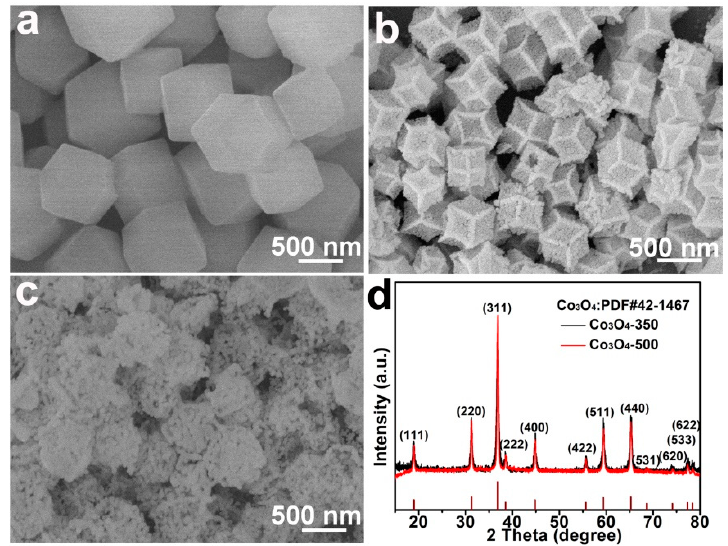
Figure 1. Typical SEM images of the Co-based zeolitic-imidazolate frameworks (ZIF-Co) polyhedron ( a ), the Co 3 O 4 -350 polyhedron ( b ), and the Co 3 O 4 -500 polyhedron ( c ); The XRD patterns ( d ) of both the Co 3 O 4 -350 polyhedron and the Co 3 O 4 -500